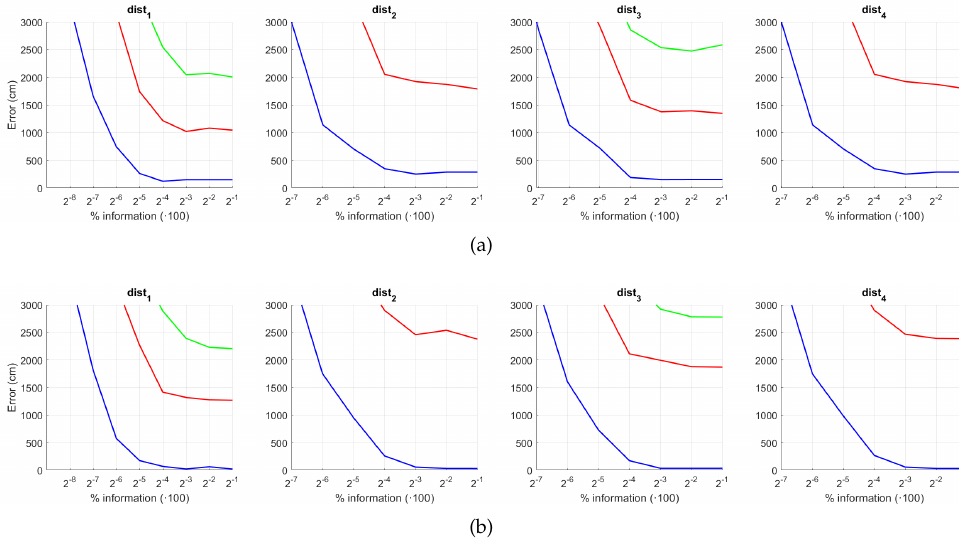
Figure 26. WS average localization error with noise: ( a ) no filter and ( b ) homomorphic